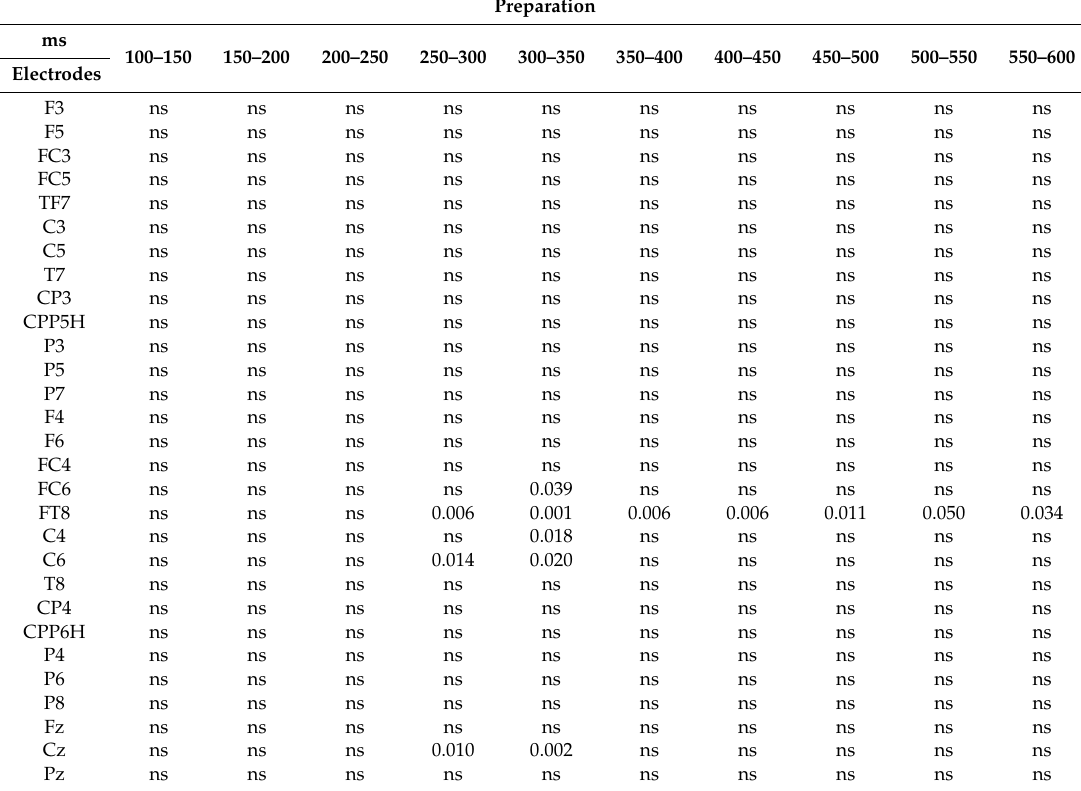
Table A1. EEG Results of the 50 ms analysis. Paired-sample t -tests were performed between inner and overt speech, separately for the preparation and execution phase between 100–600 ms in 50 ms consecutive steps; numbers indicate significant p -values; ns indicates